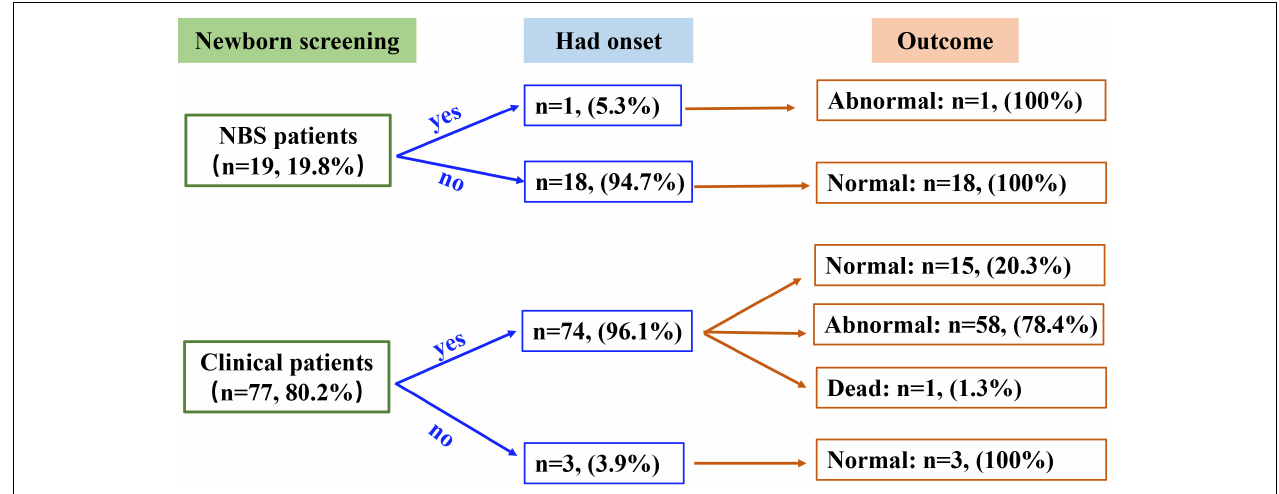
FIGURE 2 | Summary of the newborn screening status, disease onset, and clinical outcome data for the participants in this